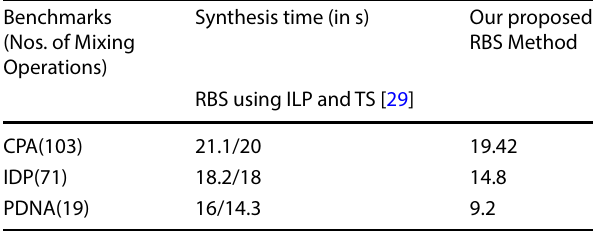
Table 9 Comparative study between RBS in ILP/TS vs our proposed method for time required for the entire synthesis process on